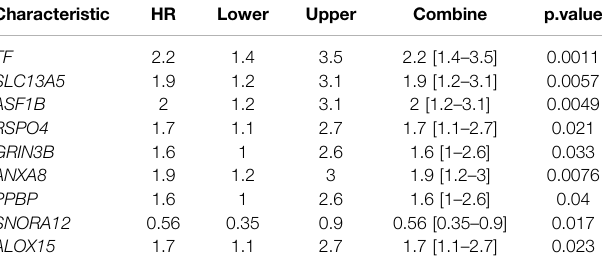
TABLE 3 | Univariate Cox results of signi fi cant DEGs. TABLE 4 | IRS formula for each sample is calculated as follows: Immune Risk Score = 0.049 + 0.071*TF (Exp)+ 0.034* SLC13A5 (Exp) + 0.074*ASF1B(Exp) +0.013*RSPO4 (Exp) +0.019* GRIN3B